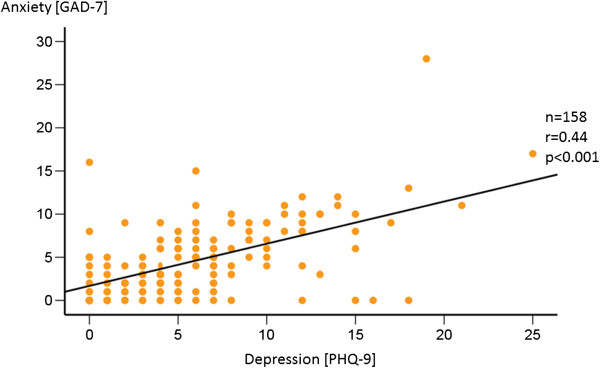
Anxiety and depression significantly correlate in patients with PH. Generalised Anxiety disorder (GAD-7) and Depression Disorder (PHQ-9) scales of each patient were analysed by correlation analysis. Score values significantly correlated (r = 0.44, p < 0.001) between groups.